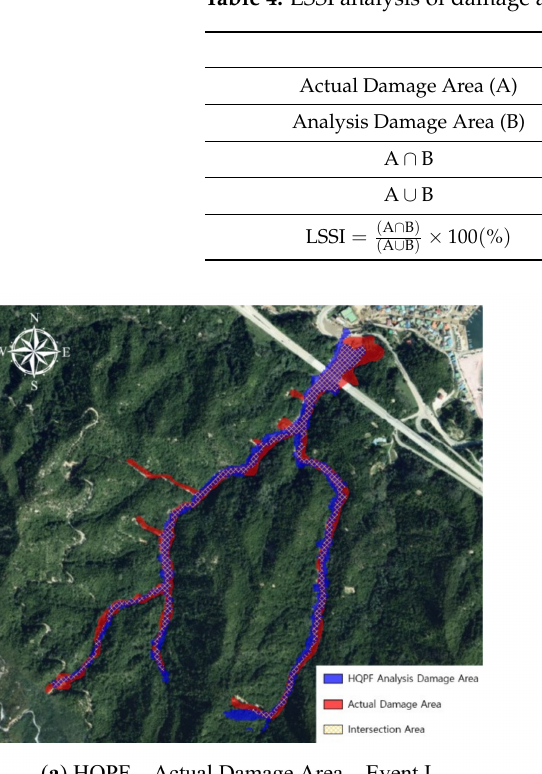
Table 4. LSSI analysis of damage area calculated through RAMMS.